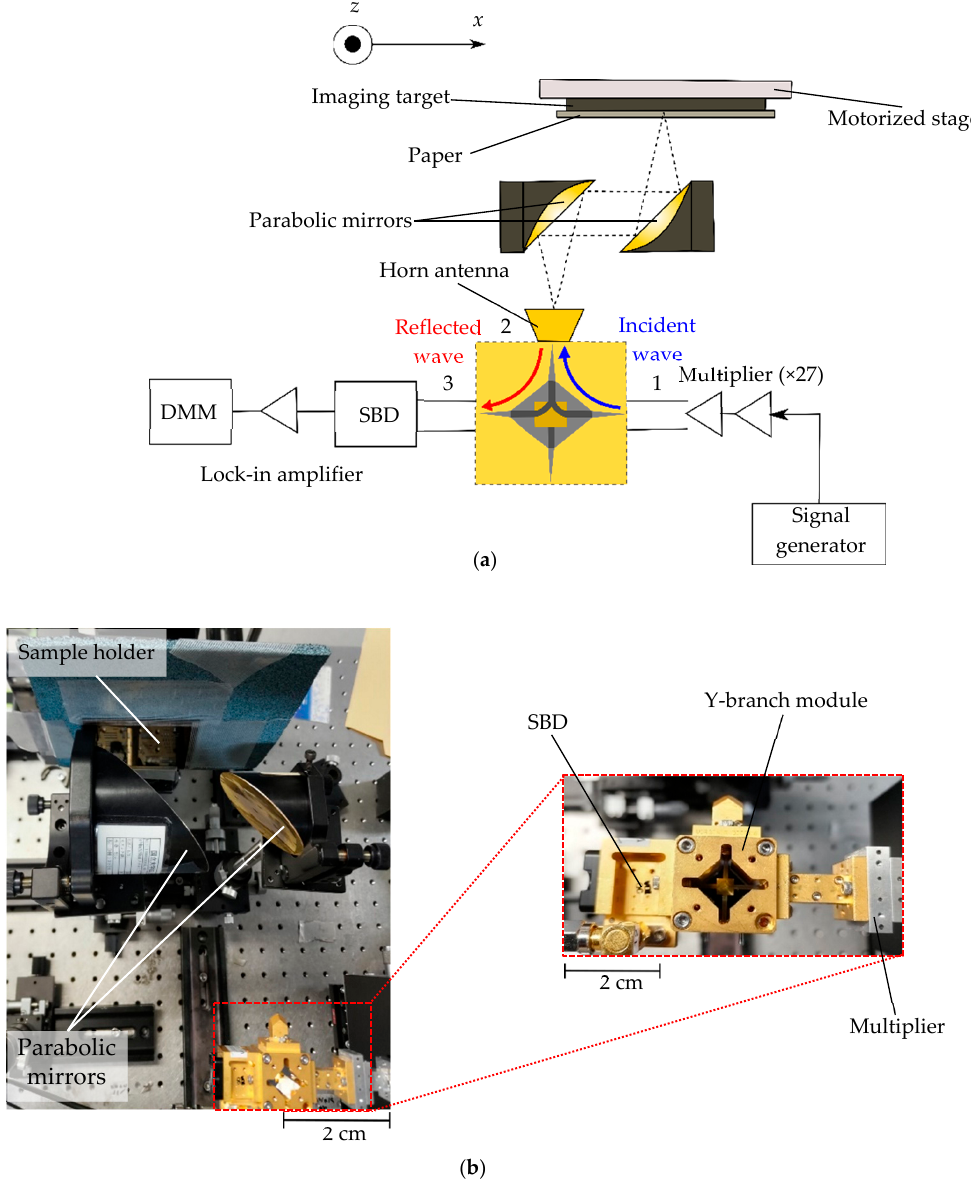
Figure 16. Imaging experimental setup: ( a ) Block diagram of the setup; ( b ) Photograph of the measurement showing the Y-branch module as inset.